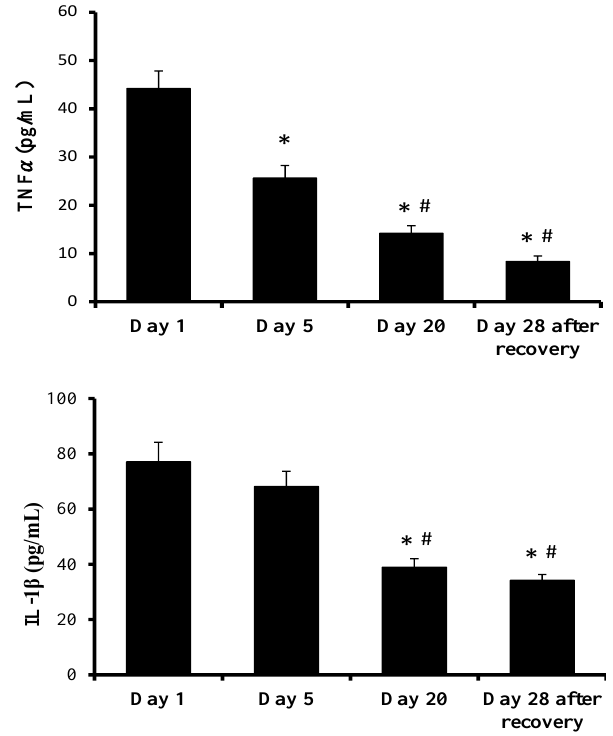
Figure 1. TNF- α and IL - 1β plasma levels following HBOT sessions 1, 5, 20 and 28 (days) after wound